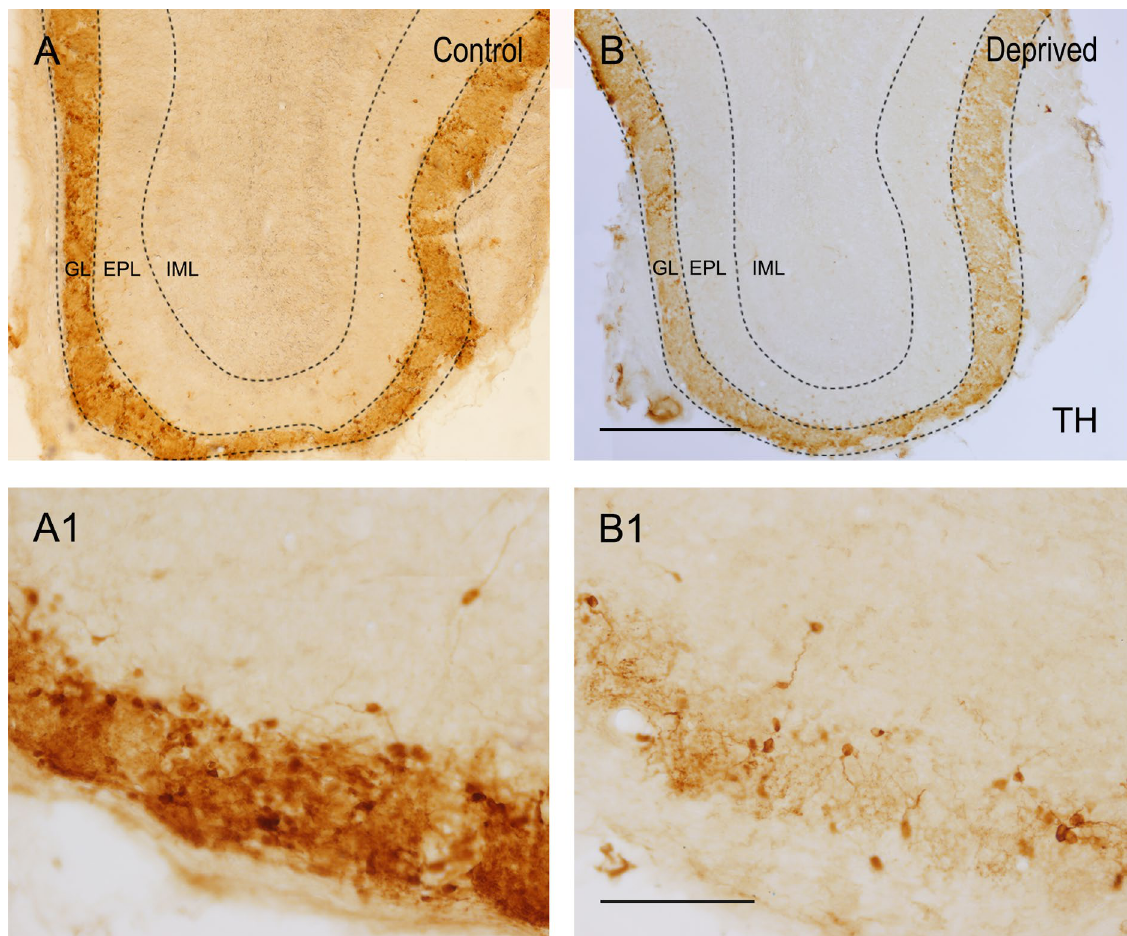
Figure 1. TH expression in the OB of control ( A , A1 ) and deprived ( B , B1 ) mice. The images show the juxtaglomerular cells positive for TH. As can be observed, the expression of TH is lower in deprived mice. GL glomerular layer, EPL external plexiform layer, IML inframitral layers. Scale bar ( A , B ) 500 µm and ( C , D ) 200 µm.